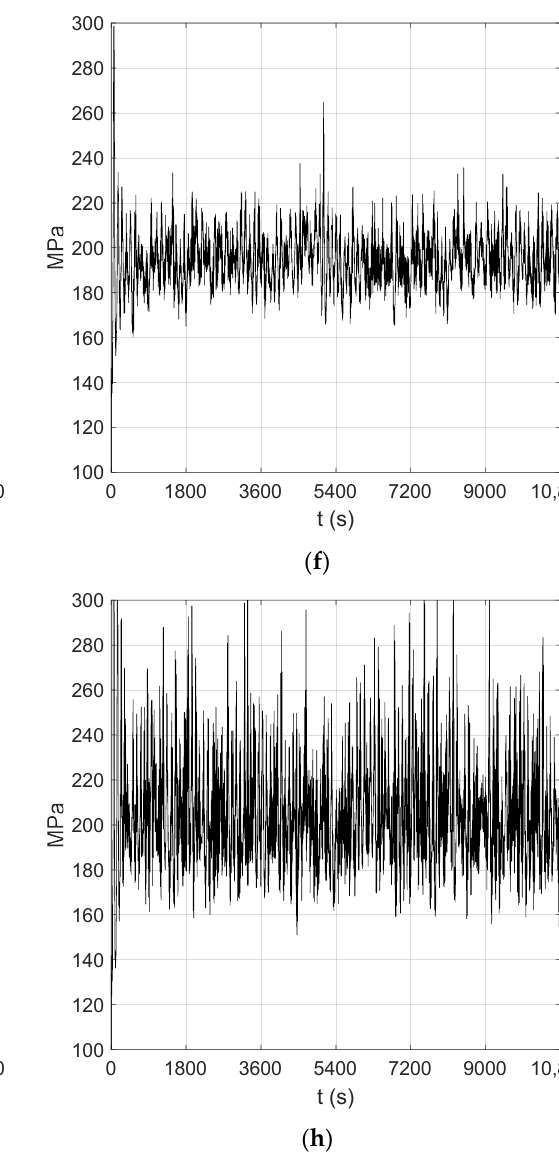
Figure 6. Stress history in line #1. ( a ) Load condition LC1; ( b ) load condition LC2; ( c ) load condition LC3; ( d ) load condition LC4; ( e ) load condition LC5; ( f ) load condition LC6; ( g ) load condition LC7; ( h ) load condition LC8. Table 4. Fatigue assessment by time-domain